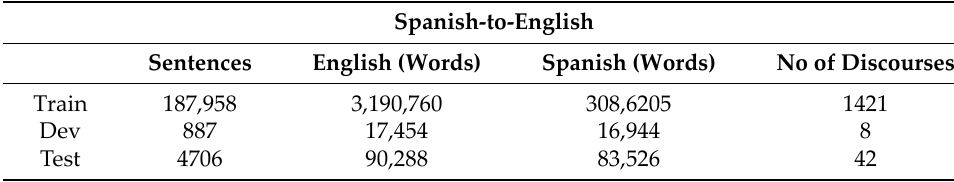
Table 2. Corpus statistics for Spanish‑to‑English.